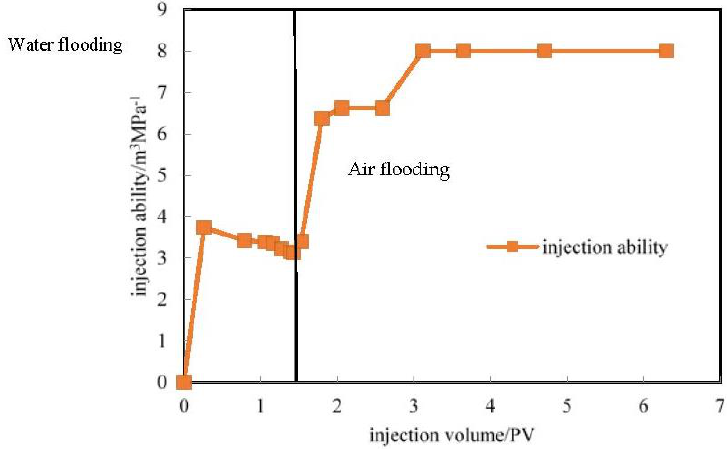
Figure 11. Injection ability and multiple injection relationship diagrams.